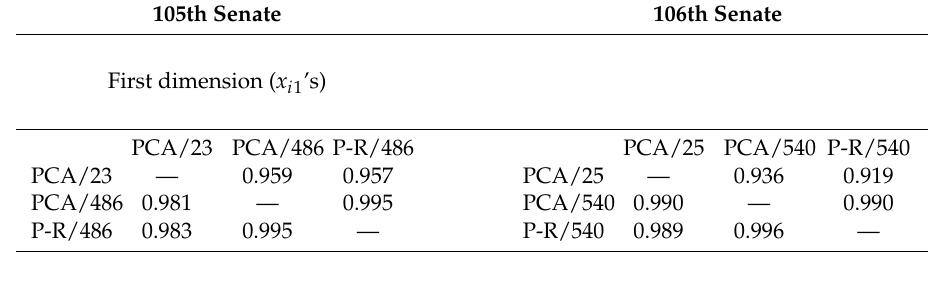
Table 2. Pearson and Spearman correlation coefficients (lower left and upper right triangle, respectively, in each 3 × 3 square) for senator location estimates, among “key vote” PCA, full PCA, and Poole-Rosenthal W-NOMINATE, for one and two dimensions and 105th and 106th Senates. 105th